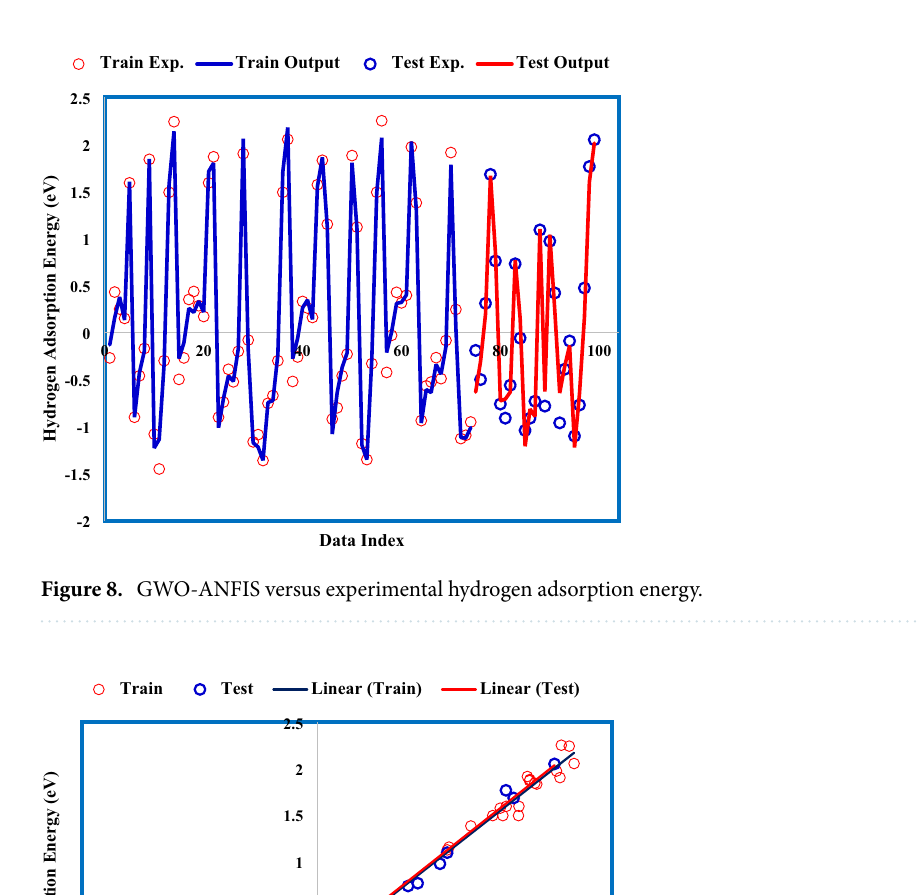
Table 1. Statistical analyses of GWO-ANFIS model.